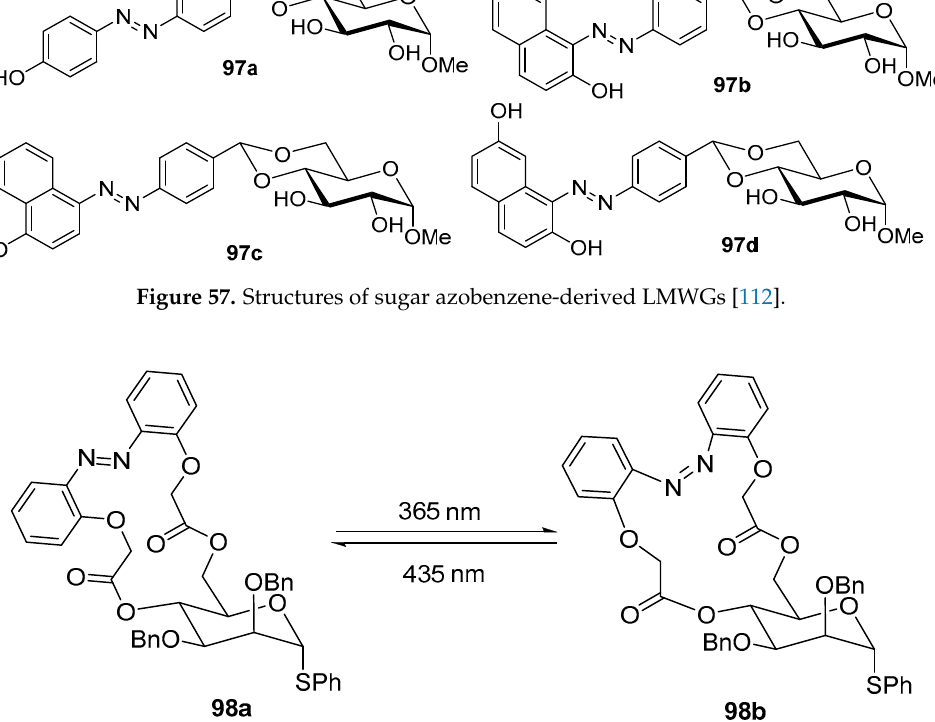
Figure 58. The cis-trans isomerization of the macrocyclic compound [113].